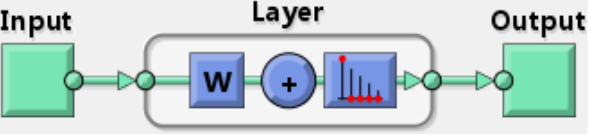
Fig. 1. A Kohonen Network using Matlab’s notation, build to clas- Fig.1 . A Kohonen Network using Matlab’s notation, build to classify a vector of 768 sify a vector of 768 members to 36 classes. The number of the ouput members to 36 classes. The number of the ouput nodes of the SOM equals the number of nodes of the SOM equals the number of classes. classes.